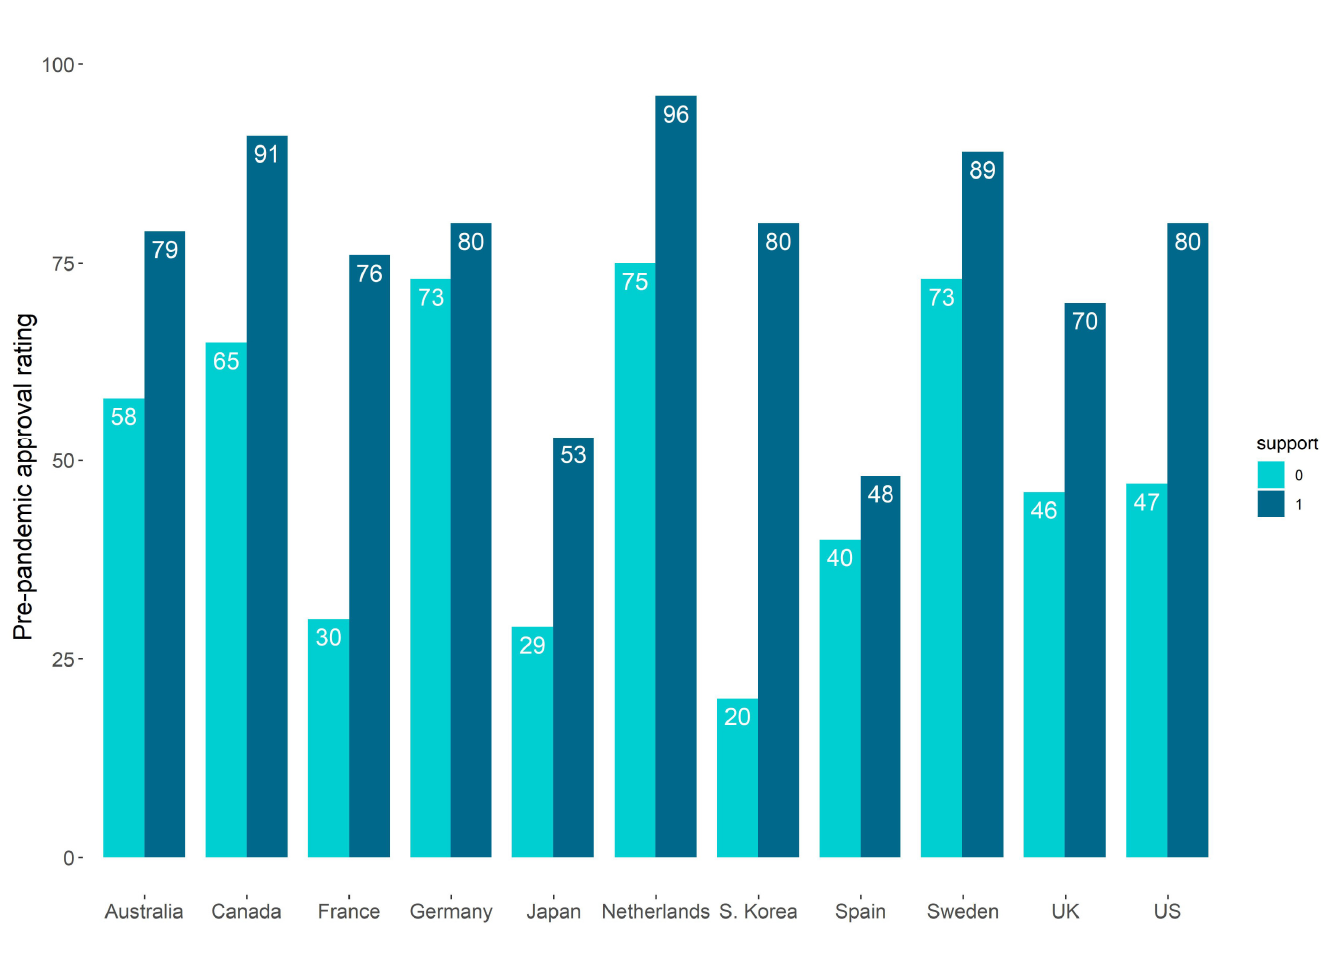
Fig 2. Pre-pandemic approval ratings in 2019 grouped by governing party supporters (1) and non-supporters (0).